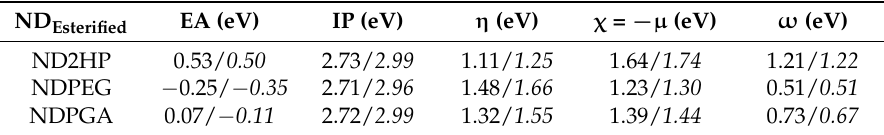
Table 2. Reactivity parameters of esterified ND calculated with energies approximation/ HOMO- LUMO approximation.